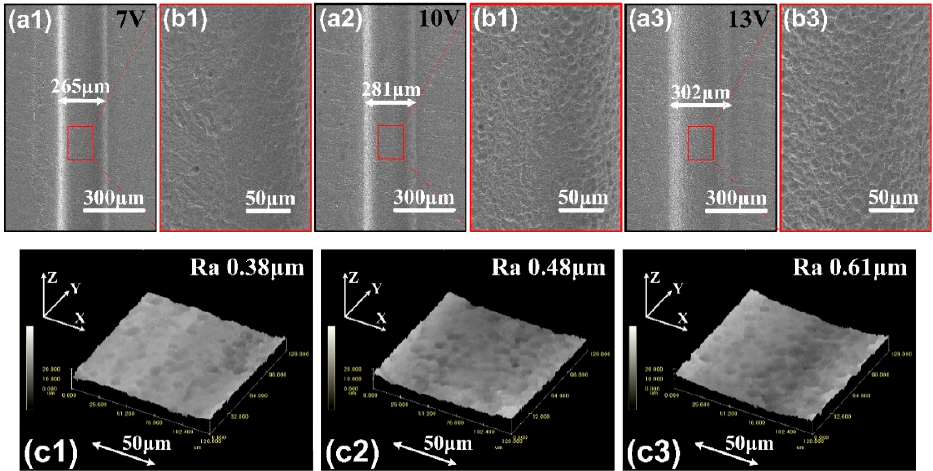
Figure 9. ( a1 – a3 ) SEM images of the micro-groove profiles with the voltage of 7 V, 10 V and 13 V. ( b1 – b3 ) SEM images of the surface quality with corresponding voltage. ( c1 – c3 ) 3D morphologies of the bottom surfaces of the micro-grooves.